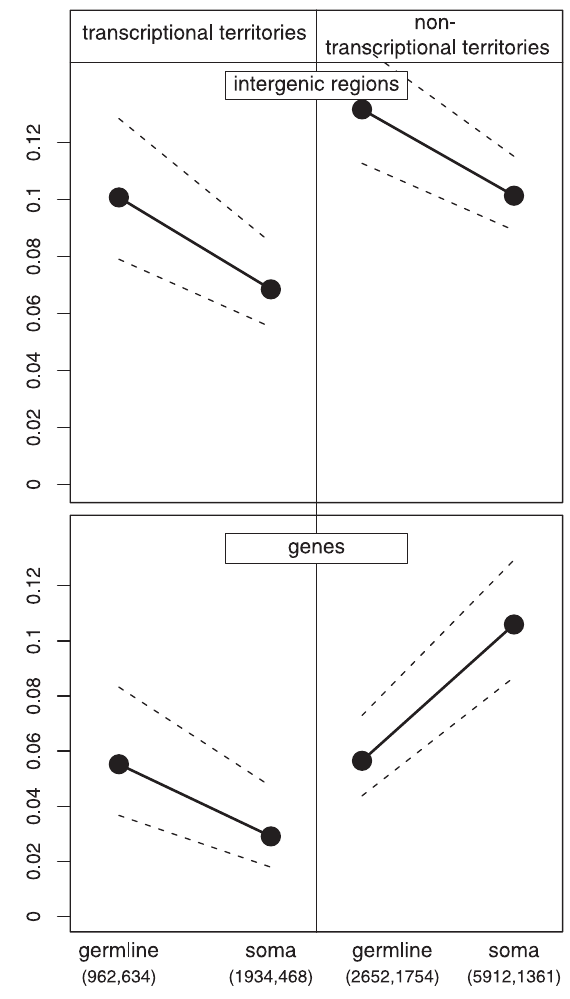
Figure 4. Number of TE Insertions for Genes and Intergenic Regions in Transcriptional and Nontranscriptional Territories This figure is a representation of a GLM analysis including recombination , noncoding length , proportion of conserved sequences, chromosome (X versus autosomes) , territory (transcriptional territories versus nontran- scriptional territories), tissue of expression (germline versus soma), and element (gene versus intergenic regions) (see Table S6). The triple interaction among the last three factors is significant ( F ¼ 8.8, p , 0.01). The figure shows the coefficients and their 95% confidence intervals and the number of intergenic regions and genes,